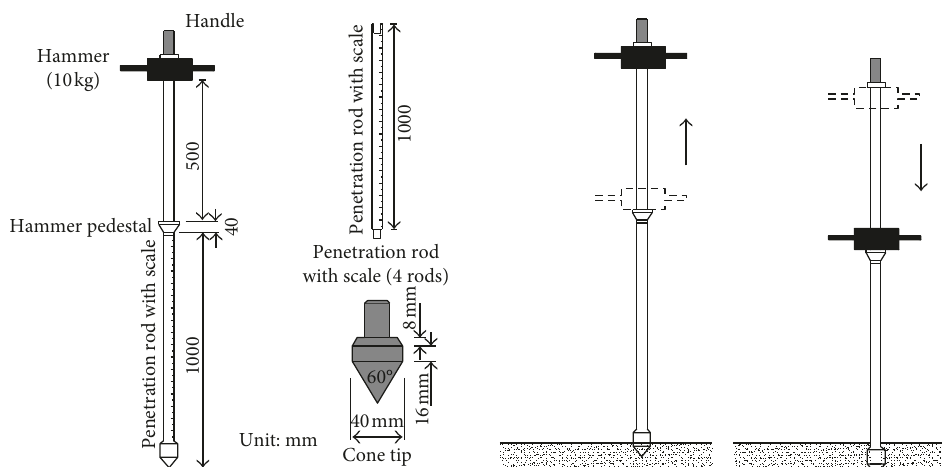
Figure 1: Diagram of the LDP device and